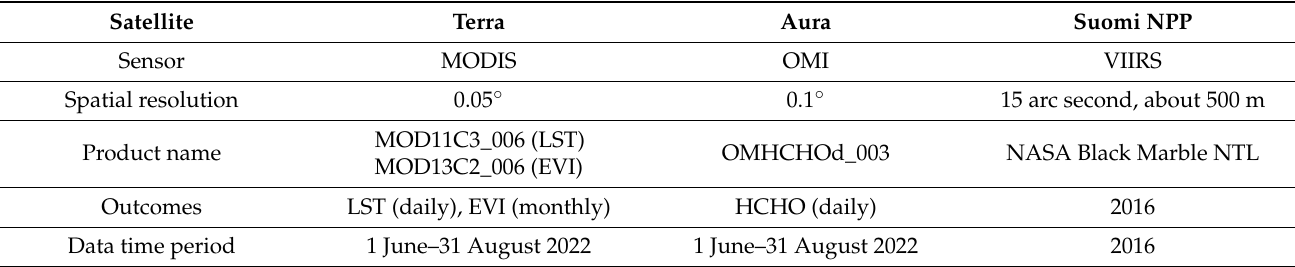
Table 2. Details of satellite imagery and products used in current